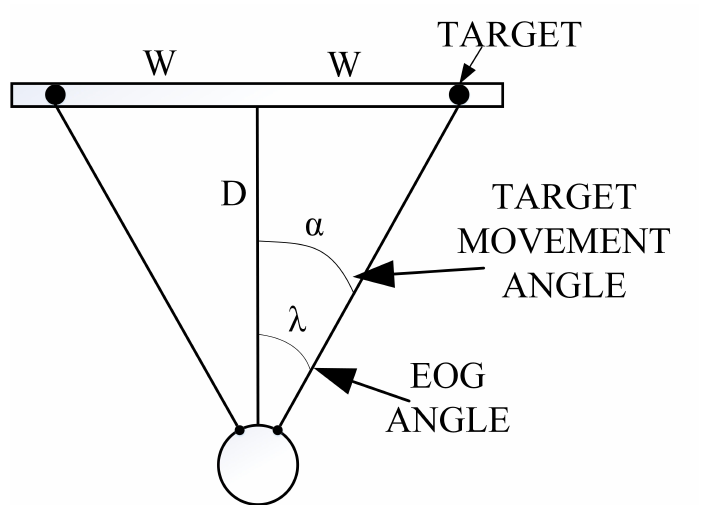
Figure 1. Relation among the width (2W) of the screen, the distance (D) of the patient, and the maximum angle of vision (2 α